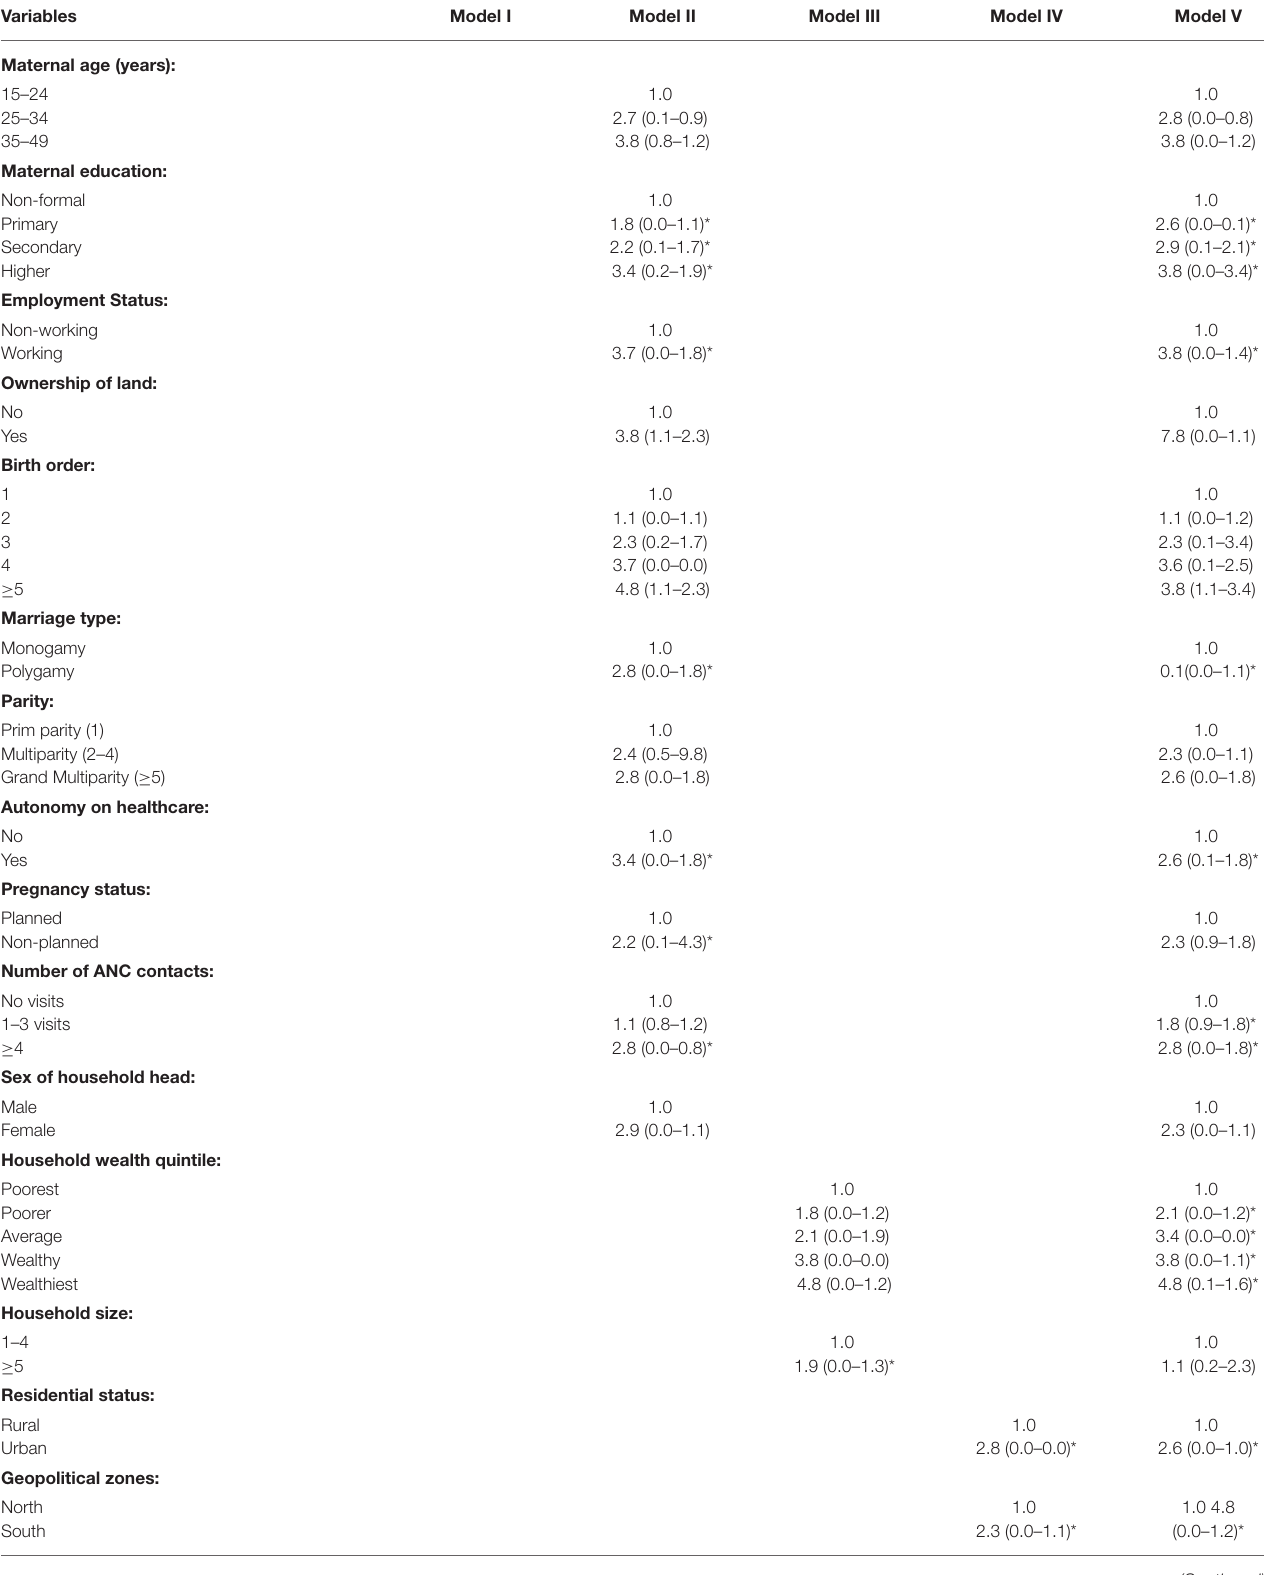
TABLE 2 | Fixed effects of individual, household, and community-level factors associated with health facility delivery among women not enrolled in health insurance.